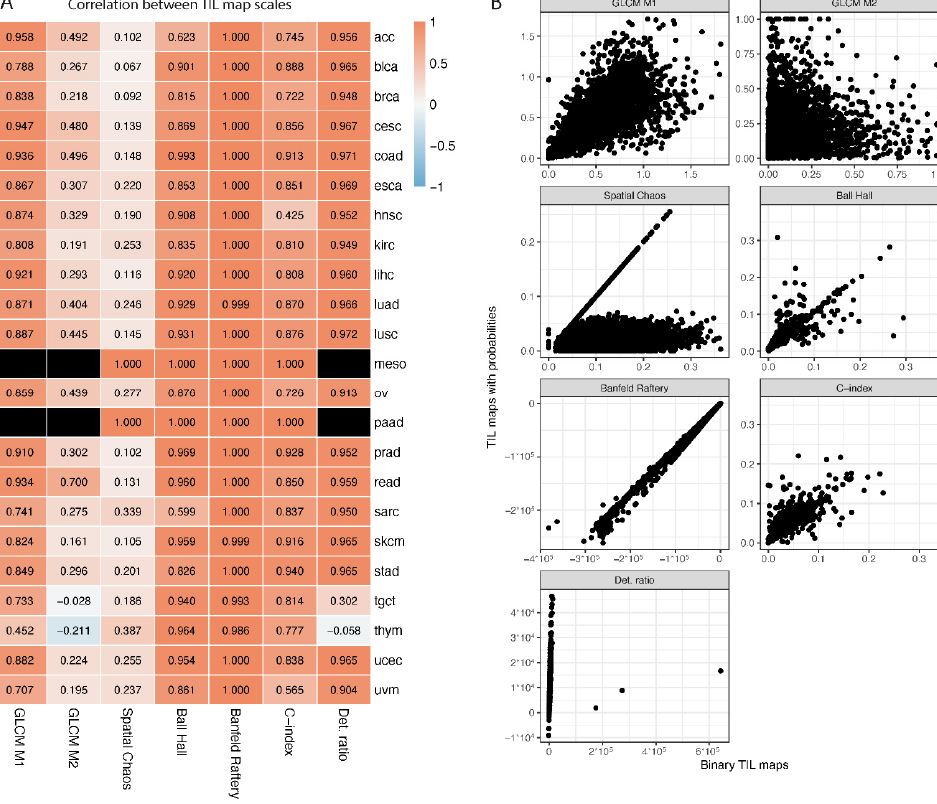
Figure 2. Comparison of spatial measures between two formats of TIL maps. ( A ) Spearman correla- tion of each spatial-measure value within each cancer type between binary and probability TIL maps. Black rectangles represent cases where NA values were present for all images within cancer type for at least one TIL map scale. ( B ) Scatter plots visualizing results for individual TIL maps within each spatial measure.